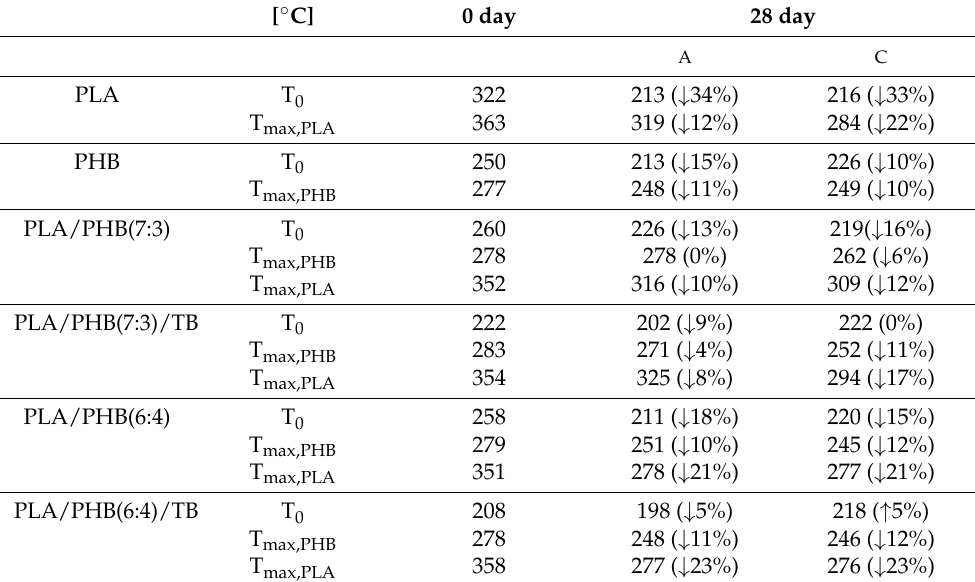
Table 6. TG and DTG parameters for annealed (A) and composted (C) films before and after 28 incubation days (values in parenthesis refer to temperature variation percentages with reference to time